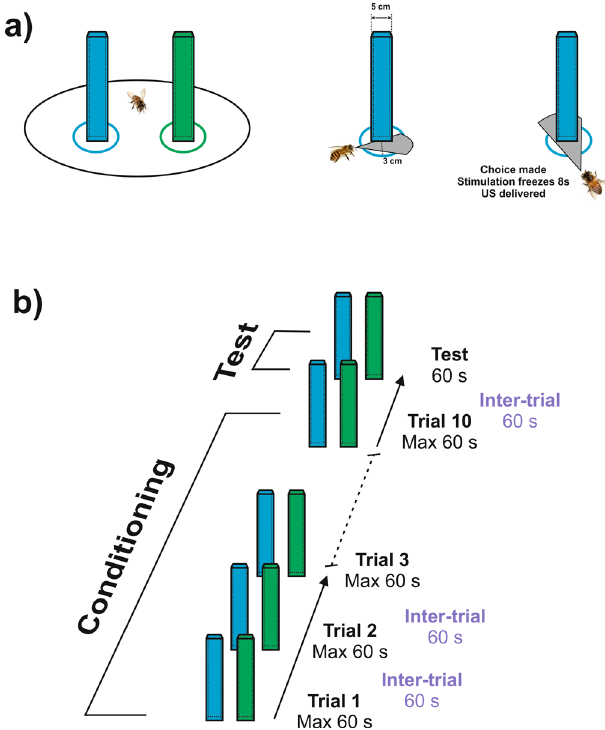
Fig. 2 Choice criterion and conditioning protocol for color discrimination learning. a Choice criterion. Left: A bee facing the two virtual cuboids. Center: A bee approaching a target cuboid; the cuboid has not yet been centered by the bee (gray area). Right: A bee having centered the target cuboid (gray area). A choice was recorded when the bee reached an area of a radius of 3cm centered on the cuboid and fi xed it frontally. The cuboid image was then frozen during 8s and the corresponding reinforcement (US) was delivered. b Conditioning protocol. Bees were trained along 10 conditioning trials that lasted a maximum of 1min and that were spaced by 1min (intertrial interval). After the end of conditioning, and following an additional interval of 1min, bees were tested in extinction conditions with the two colored cuboids during